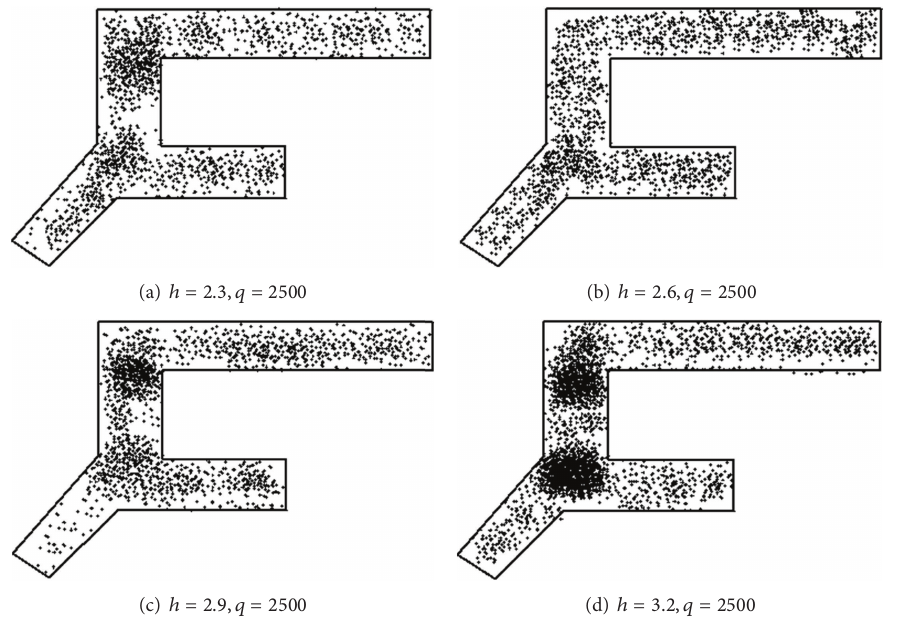
Figure 17: Inner space status of signs at different intensity levels ( 𝑞 = 2500